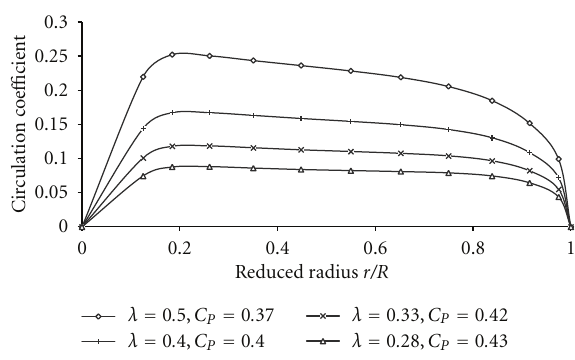
Figure 4: Comparison of the circulation coe ffi cient distribution on the lifting line between the OPHWT model and the kinetic energy model for λ 0 = 0 . 5 and C P = 0 . 37.